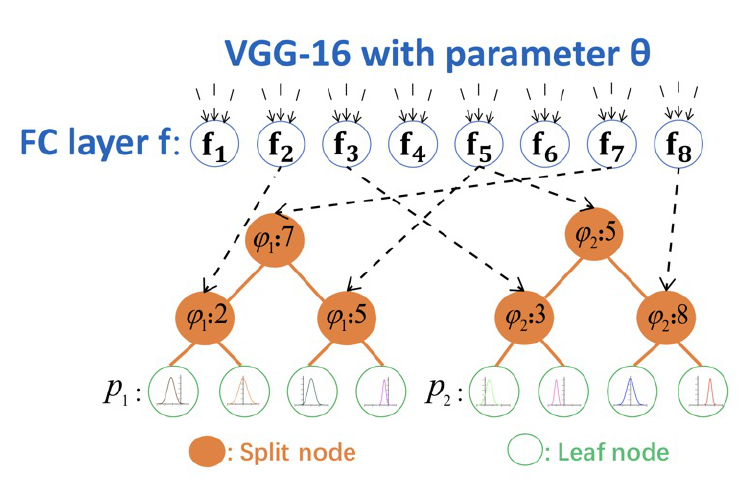
Figure 4. Illustration of deep regression forests. The upper blue circles represent the output neurons from the CNN defined by the function f with parameter θ . All these neurons come from the last fully-connected (FC) layer of VGG-16. The middle orange circles represent the split nodes and the bottom green circles represent the leaf nodes of deep regression forests. ϕ 1 and ϕ 2 represent the index functions of each tree. The black dashed arrows point out the correspondence from the split nodes of each tree to the neurons of VGG-16 FC layer. Each neuron may correspond to the split nodes of different trees. Each tree has its own distribution π for its leaf node (represented by the distribution curves on the leaf nodes). The final output for the whole forest can be calculated as the mix of the predictions of the individual trees. The parameters f ( · ; Θ ) and π will be trained simultaneously